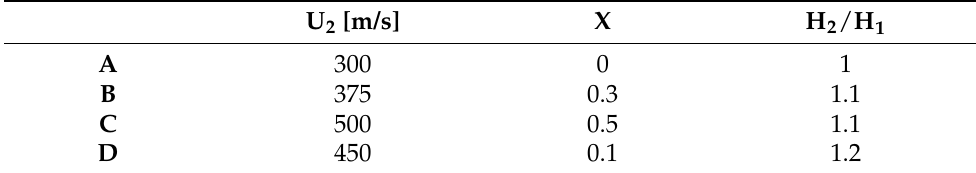
Table 2. Design points studied with 3D coupled stator-rotor simulations.